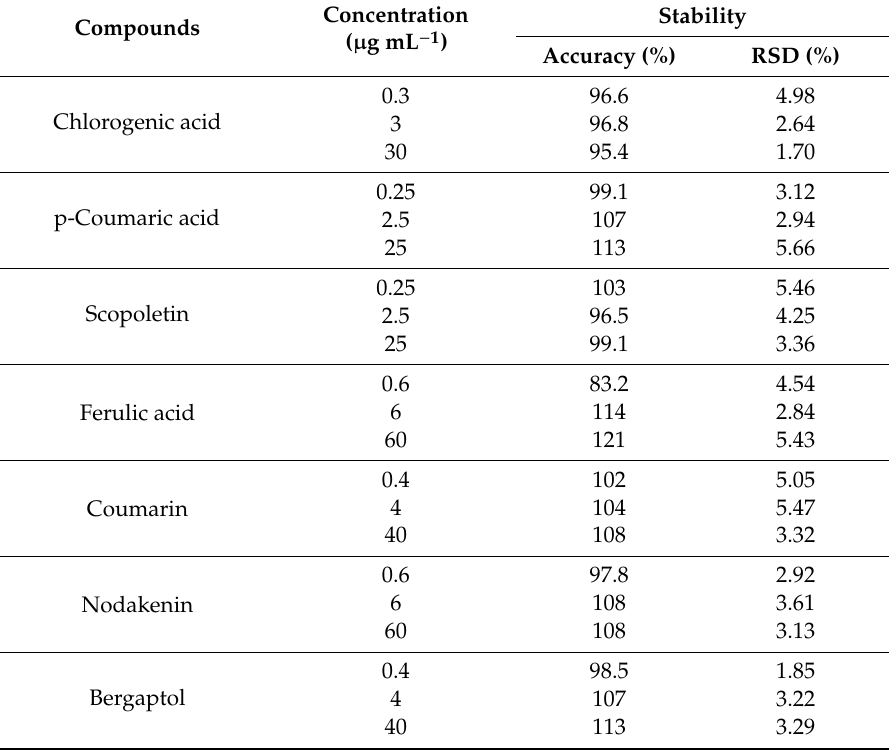
Table 3. Stability of 19 compounds using the SSMD method ( n =